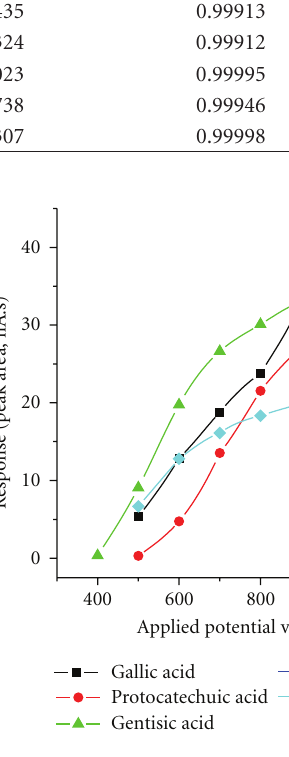
Figure 4: Hydrodynamic voltammograms of the phenolic acids